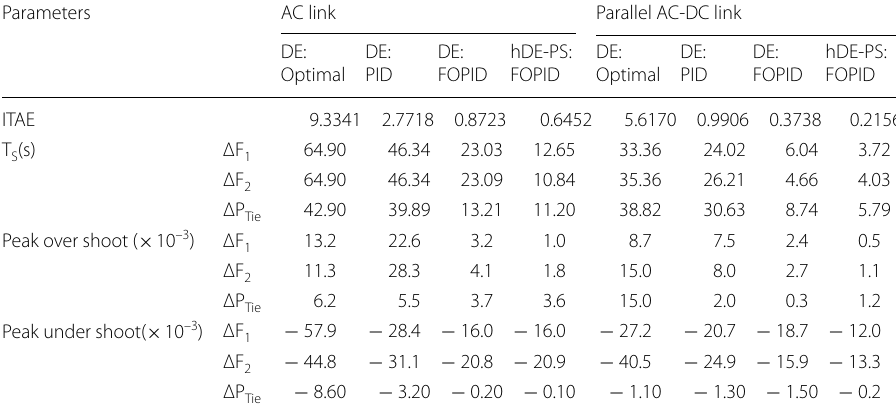
Table 3 Comparative performance index values under different